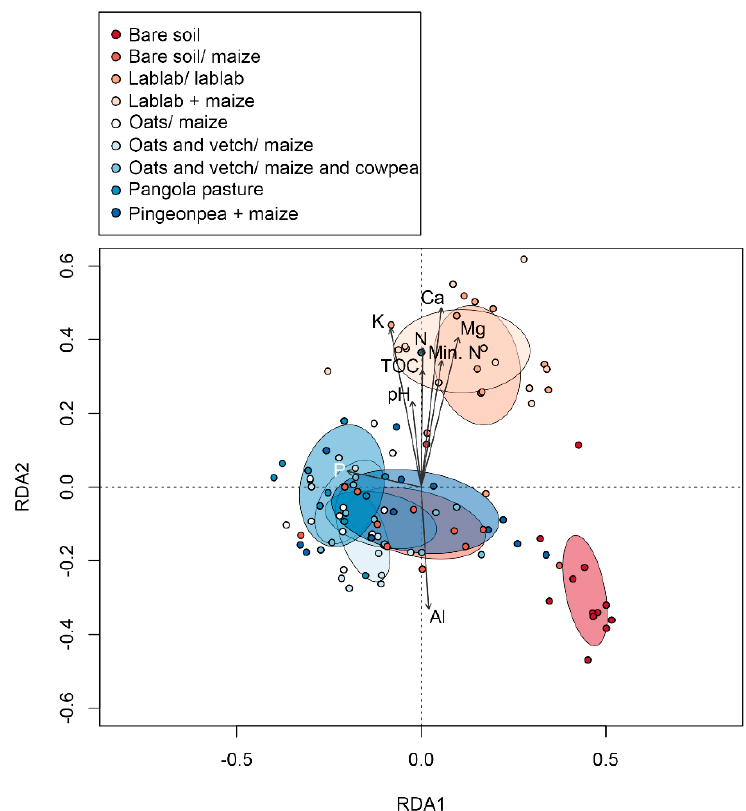
Figure 6. Redundancy analysis (RDA) evaluating the microbial community composition in eight different management treatments in relation to 10 soil parameters. The first RDA axis explained 44.9% of the variation in the community composition and was strongly associated with the bare soil and Pangola pasture treatments as well as soil P; the second RDA axis explained an additional 20.9% of the variation in the community composition, and was strongly associated with two Lablab treatments, as well as all other soil parameters. Ellipses correspond to 95% confidence limits surrounding the centroids for each planting treatment.